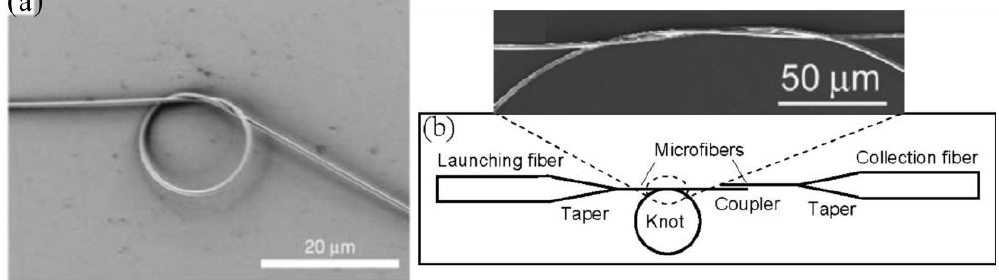
Figure 8. ( a ) Scanning Electron Microscope (SEM) image of a 15 μm diameter microfiber knot [142];